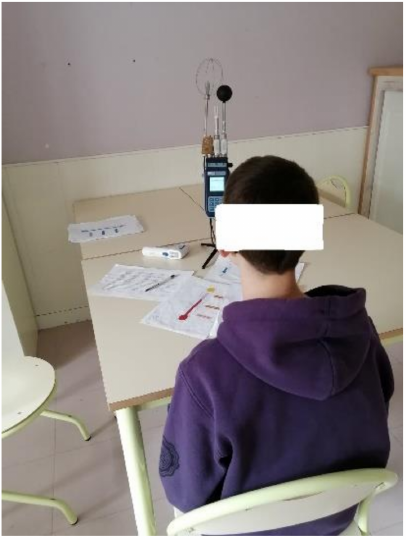
Figure 3. Survey